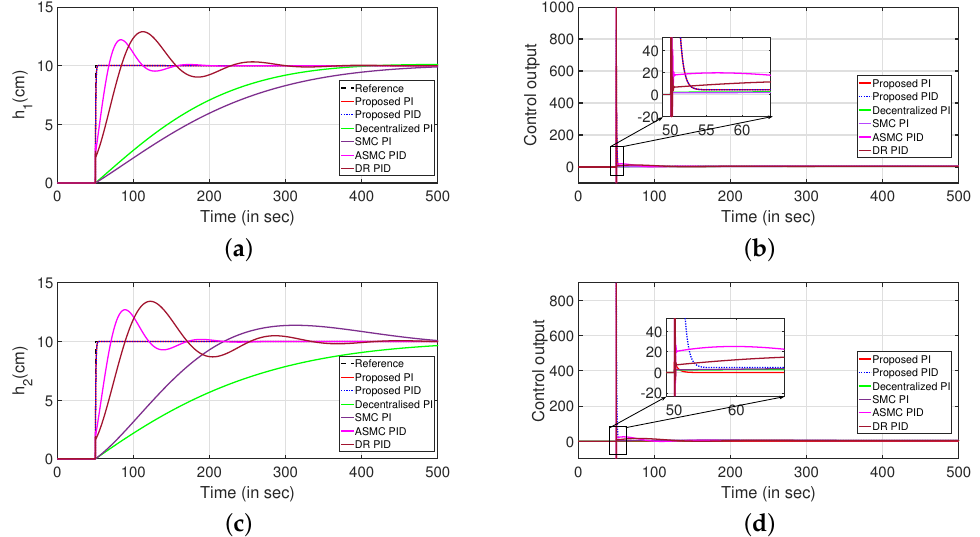
Figure 21. Servo response. ( a ) Level Variation in tank 1. ( b ) Control output. ( c ) Level Variation in tank 2. ( d ) Control